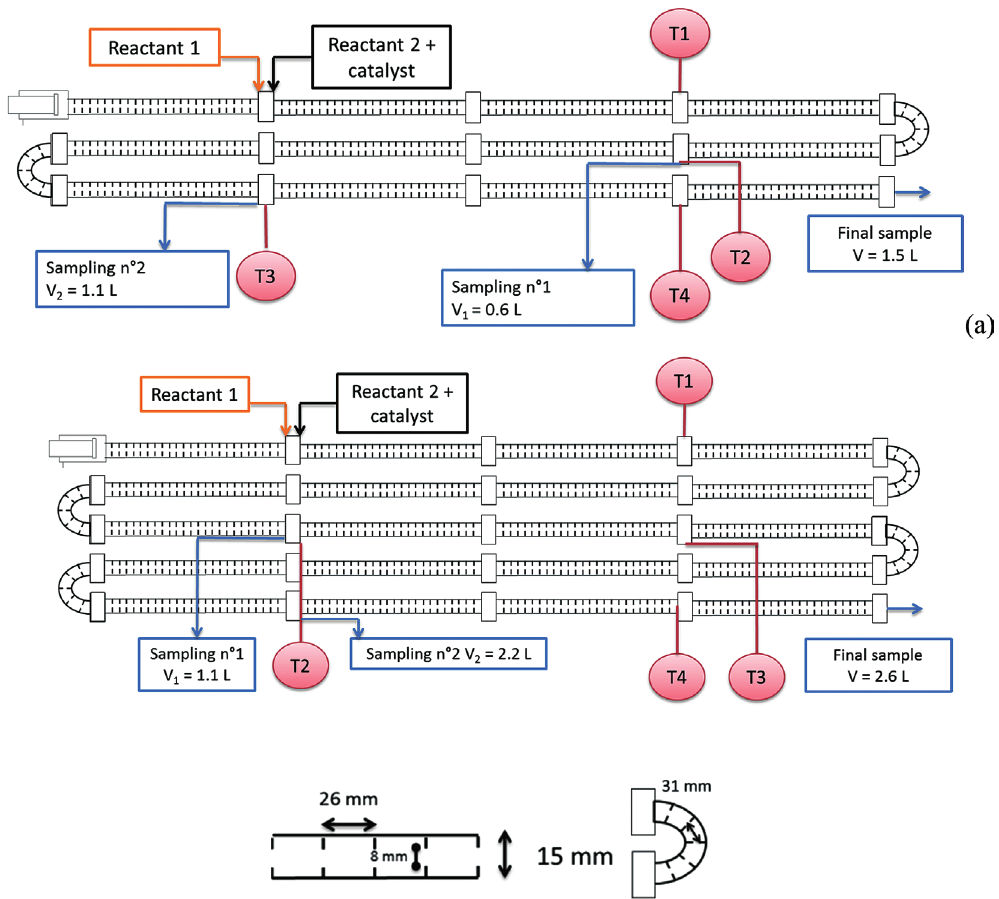
Figure 3 Experimental set-up of the COBR for (A) three tubes for the transesterification reaction, (B) six tubes for esterification reaction and (C) with the corresponding